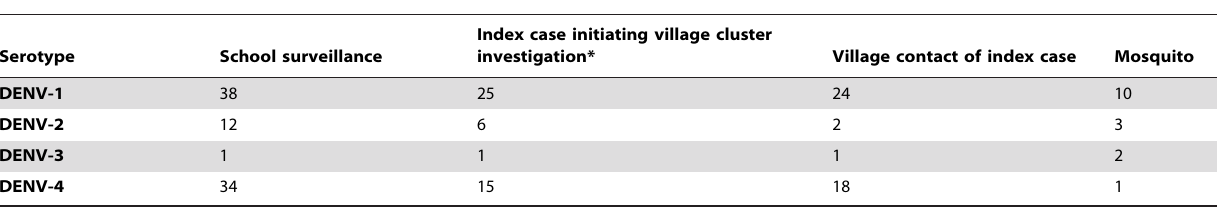
Table 2. Number of DENV sequences used in this